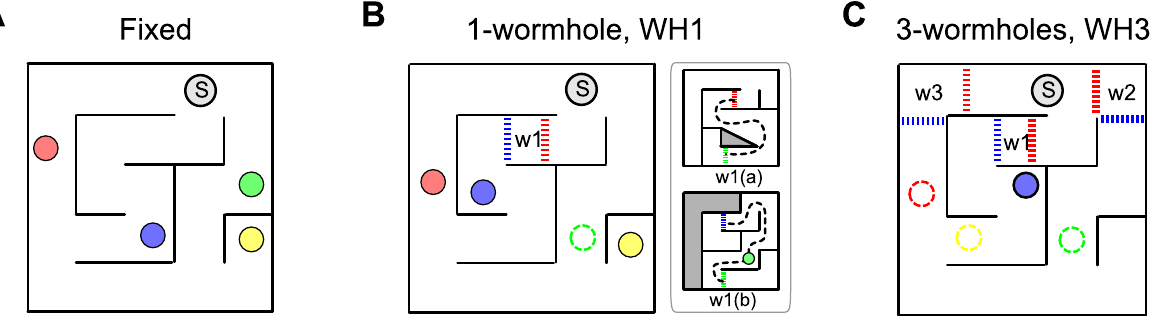
Fig 2. ‘Fixed’ and wormhole conditions. The general layout (containing Start, which is marked as ‘S’) remained constant between conditions. A) ‘Fixed’ condition in Layout 1. B) One-wormhole condition in Layout 1; the green target is inside the wormhole and the red and blue dashed lines show the location of the triggers to change the virtual environment to one of the scenes indicated in the subplot w1(a) or w1(b). The only region in which a participant could walk once they entered a wormhole is shown by the black dashed line. See text for details. C) Three-wormhole condition for Layout 1; red, green and yellow targets are inside wormholes (for details of the three wormholes see S1 Fig). For movies illustrating particpant trajectories in the Fixed, one-wormhole and three-wormhole conditions and for the layout of the maze in Layout 2, see (S2 Video for the Fixed scene shown in A, S3 Video for the one-wormhole condition shown in B and S4 Video for the 3-wormhole condition shown in C).